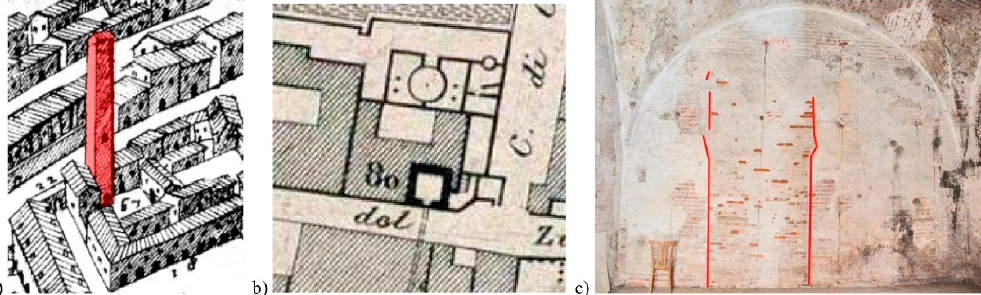
Figure 5. Zuccaro’s Tower in Mantua in historic maps: ( a ) G. Bertazzolo, Mantua Descriptio Urbis, 1628; ( b ) G. Raineri, Map of the Royal city of Mantua, 1831 (Mantua State Archive) The first picture of the building conforms to the current layout with a large window in the south–west front (Figure 1a). The tower appears surrounded by low buildings, on two sides, with an opening toward a courtyard at the north–east. The opening is no more present nowadays, but its layout is clearly recognizable thought the survey of the front surfaces ( c ).